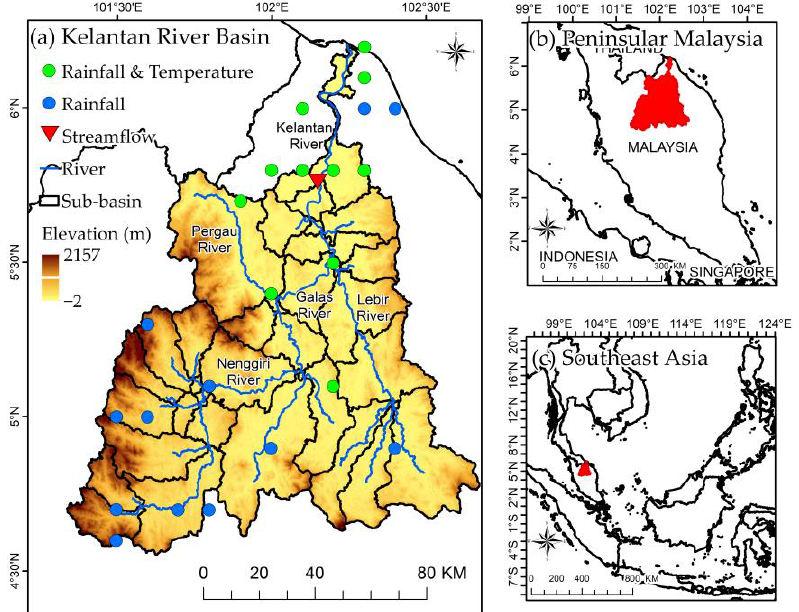
Figure 1. ( a ) Kelantan River Basin and its location within the ( b ) Malaysian and ( c ) Southeast Asian regions.